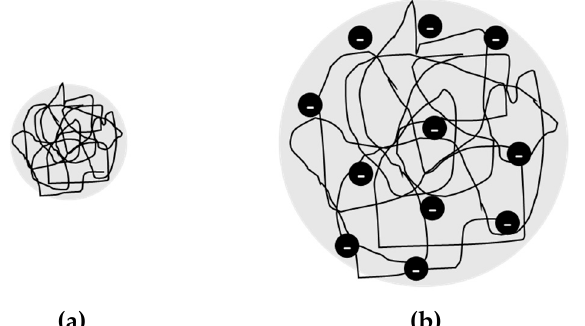
Figure 2. E ff ect of ionic polymer backbone on hydrodynamic volume; comparison of ( a ) polyacrylamide Figure 2. Effect of ionic polymer backbone on hydrodynamic volume; comparison of ( a ) and ( b ) partially hydrolyzed polyacrylamide polyacrylamide and ( b ) partially hydrolyzed polyacrylamide (HPAM).